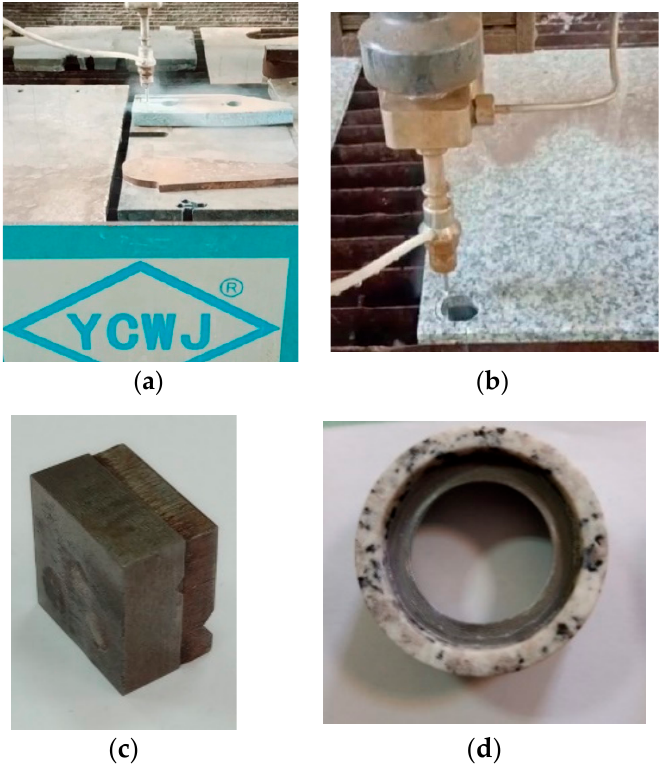
Figure 2. Processing the cast iron samples and the granite rollers: ( a , b )—cutting the samples with the water jet cutting machine; ( c )—cast iron test sample; ( d )—granite roller.